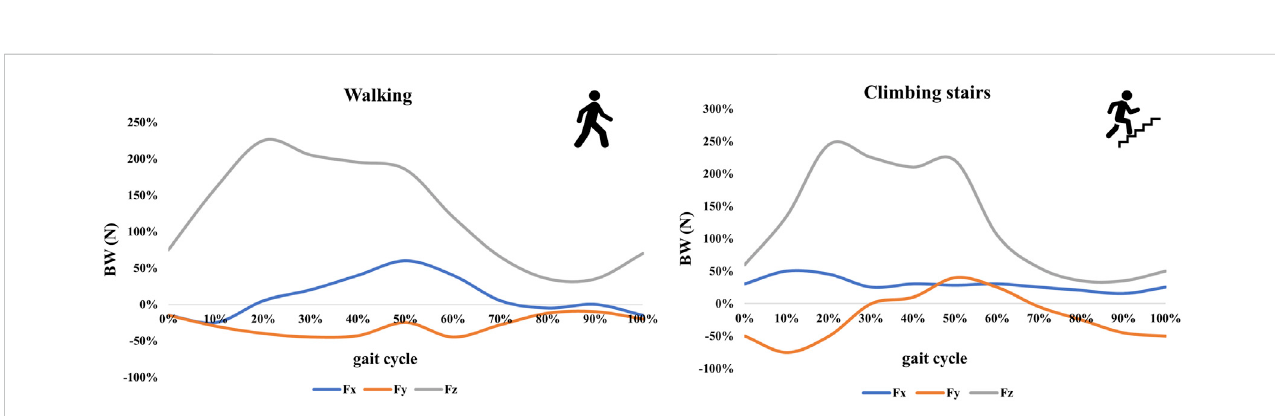
FIGURE 3 The load curves of dynamic walking and climbing stairs cycle